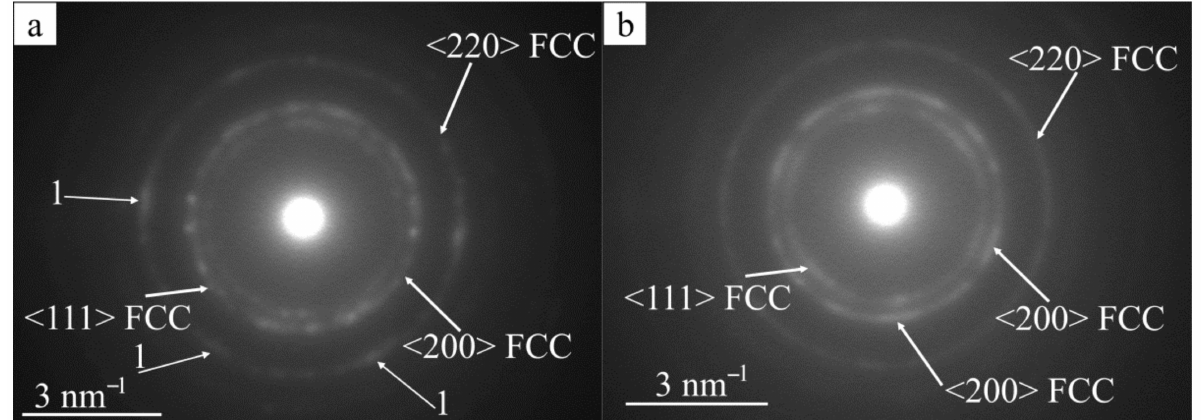
Figure 9. Electron microdiffraction patterns from different regions under the indenter’s tip: ( a ) from the nanocrystalline layer; ( b ) from the columnar